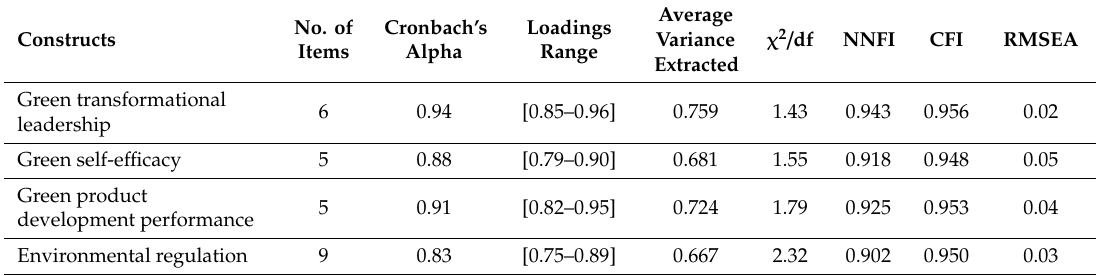
Table 1. Descriptive statistics of the